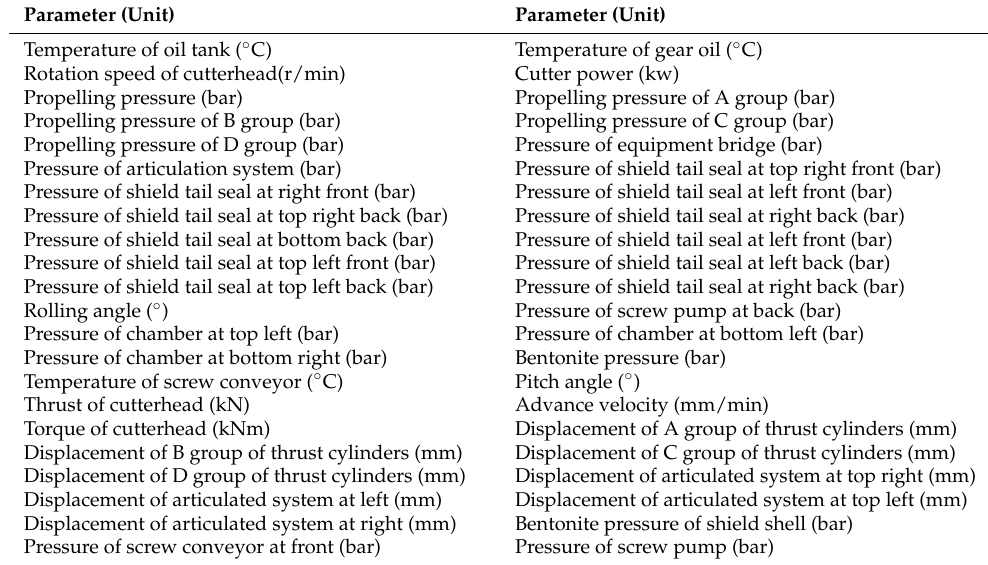
Table A1. List of operating